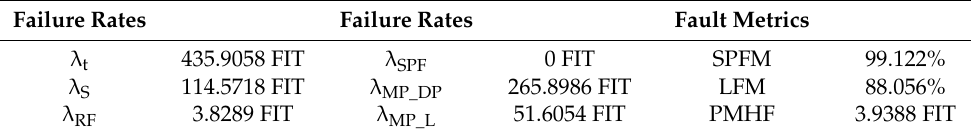
Table 8. Failure rates and fault metrics obtained in the FMEDA of the enhanced BMS